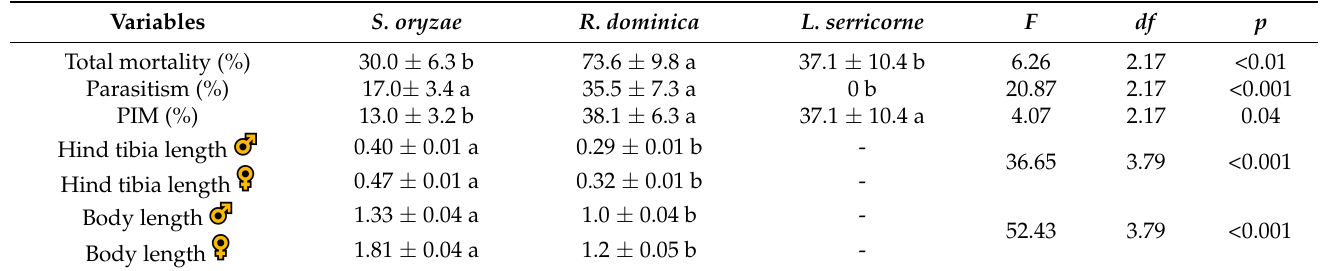
Table 2. Percentage (mean ± SEM) of host mortality, e ff ective parasitism and PIM (host feeding, unsuccessful parasitism) caused by L. distinguendus when the larvae of S. oryzae , R. dominica or L. serricorne were o ff ered. Mean (±SEM) hind tibia and body length of L. distinguendus (males and fe- males) emerging from each host species. N = 40 (20 males and 20 females). In each row, means fol- lowed by a di ff erent le tt er are signi fi cantly di ff erent ( p < 0.05, Tukey). Body size measurements are given in mm.